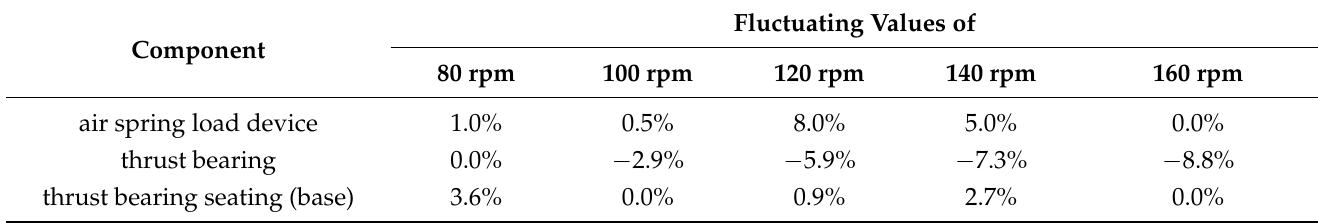
Table 2. Comparison of fitted stiffnesses of different rotational